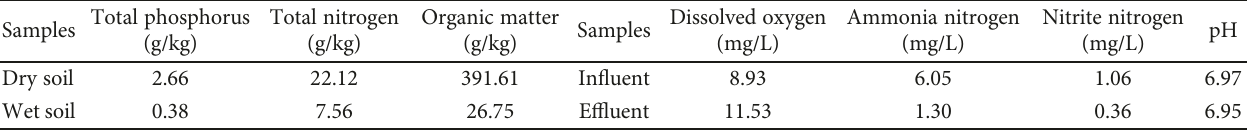
Table 1: Physical and chemical characteristics in samples.